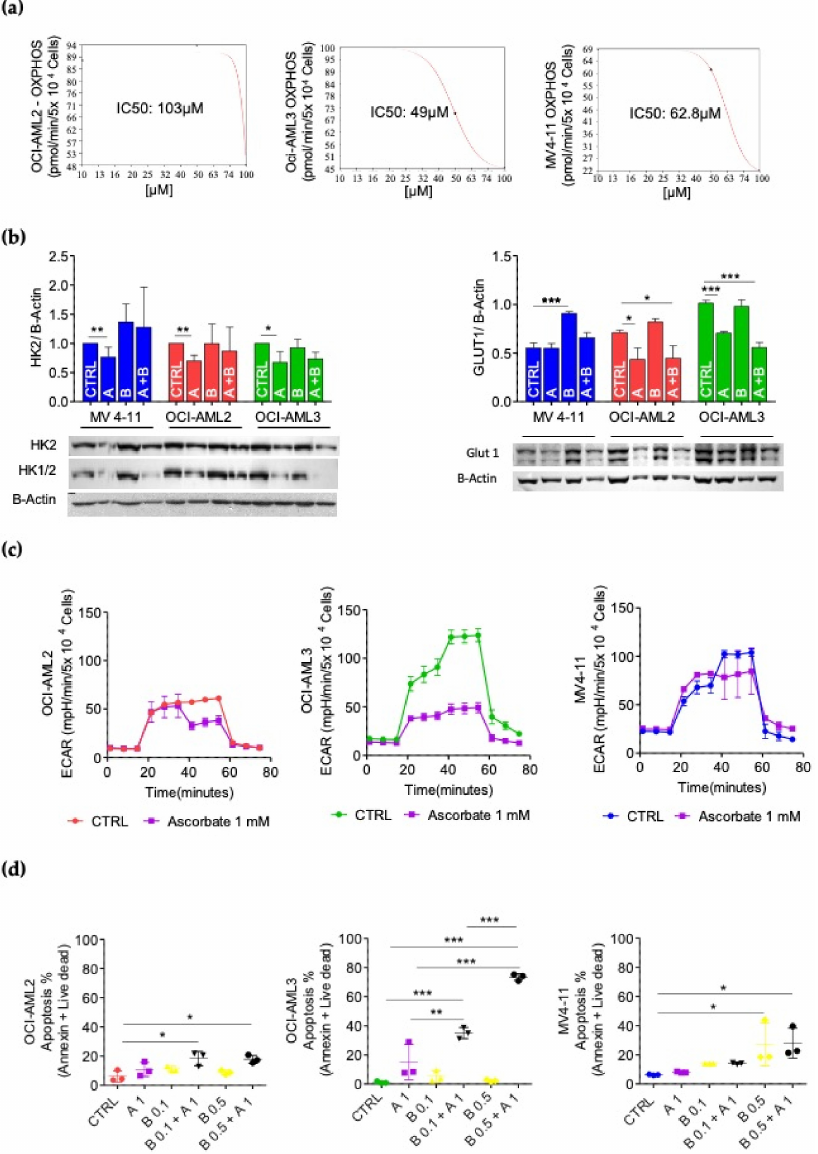
Figure 3. Metabolic effect of buformin and ascorbate in OCI-AML2, OCI-AML3 and MV4-11 cell lines. ( a ) Evaluation of OXPHOS IC50 concentration. Three independent experiments ± SD ( b ) HK2, HK1/2 and GLUT1 protein expression in OCI-AML2, OCI-AML3 and MV4-11 cell lines treated